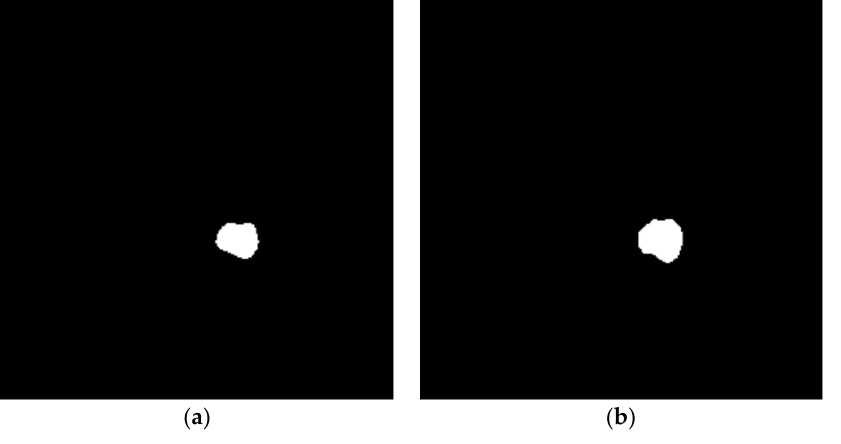
Figure 12. Performance comparison between the proposed brain tumor segmentation and Ground Truth: ( a ) segmentation using our method; ( b ) Ground Truth.